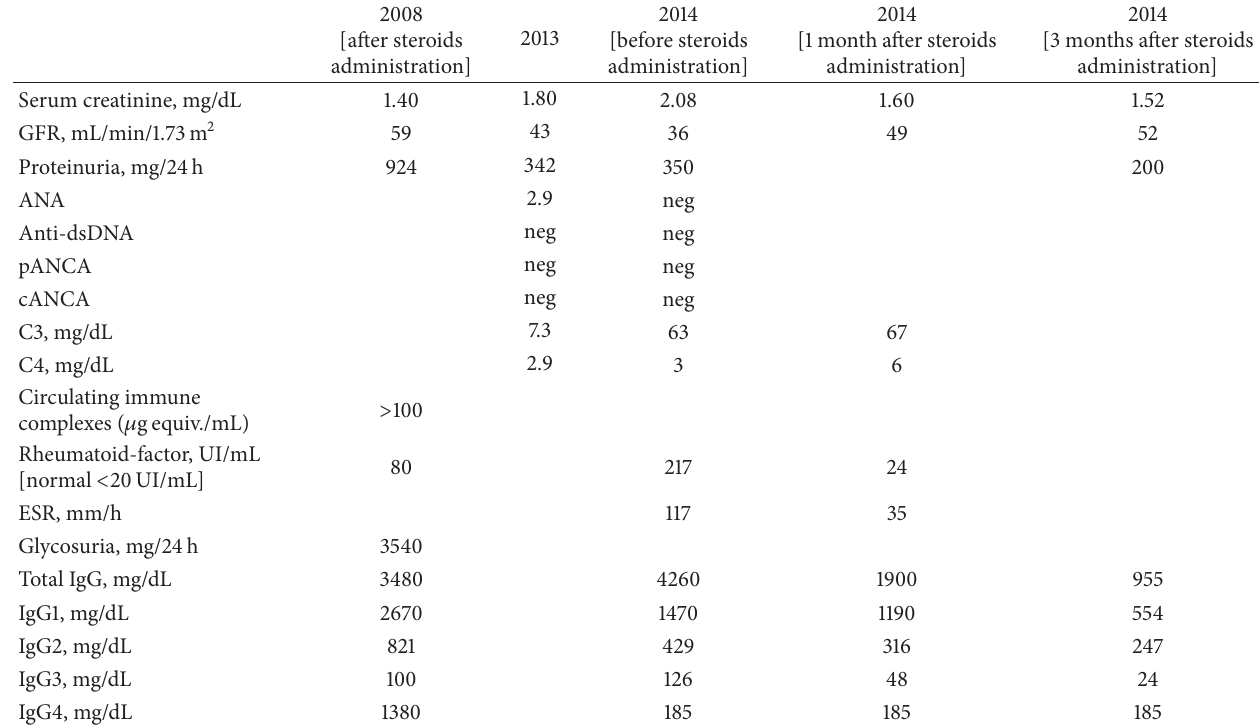
Table 1: Main laboratory data.